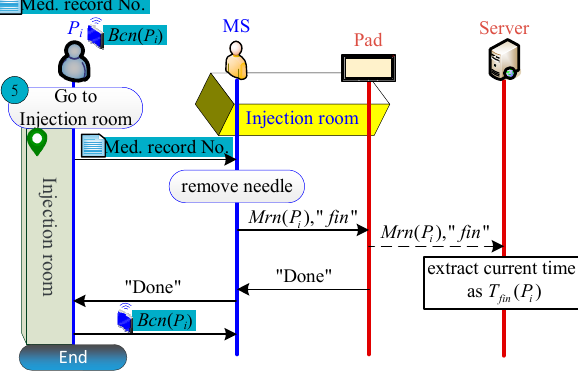
Figure 9. End examination process.